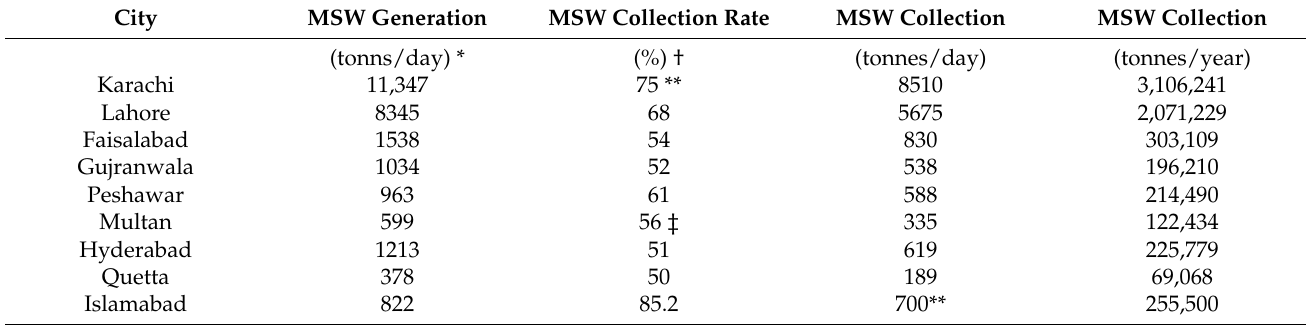
Table 5. Estimated MSW collection rate in major cities of